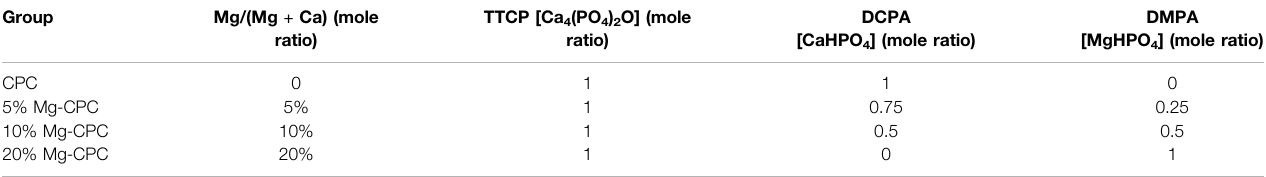
TABLE 1 | The powder composition of calcium phosphate bone cement.